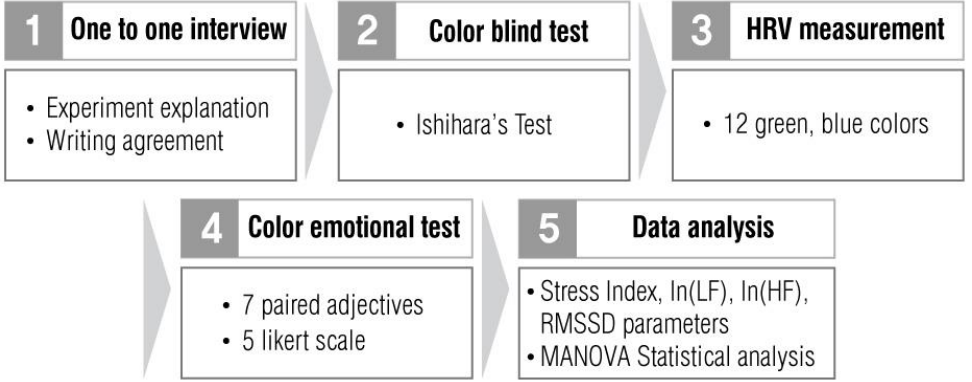
Figure 2. Study design and research procedure.